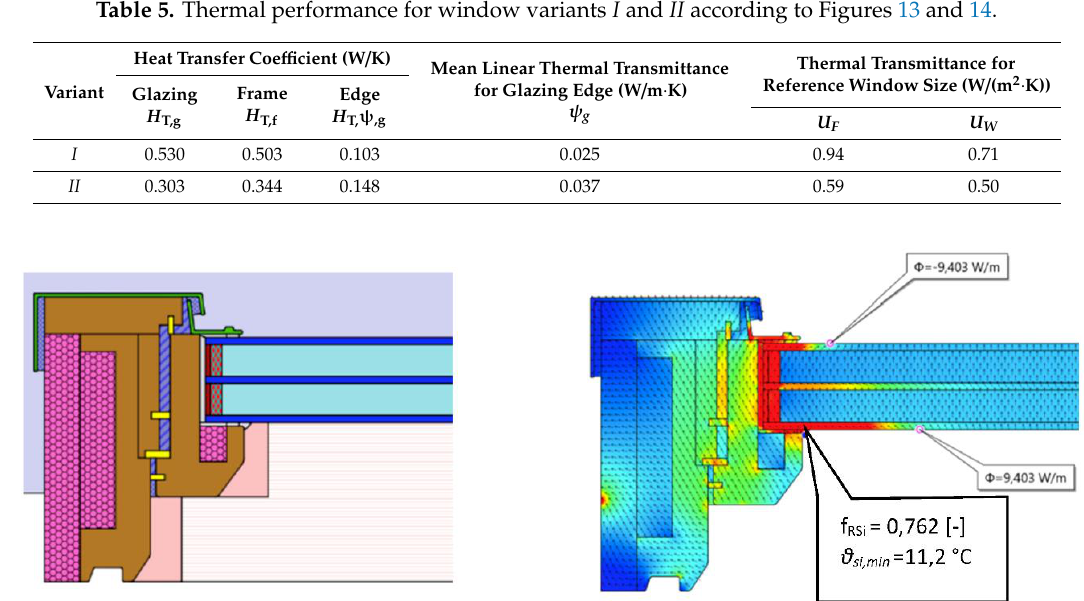
Table 5. Thermal performance for window variants I and II according to Figures 13 and 14.